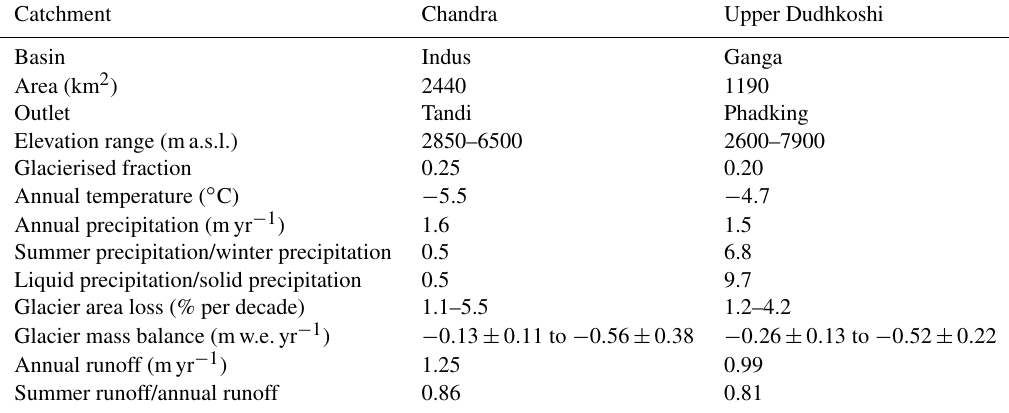
Table 1. A summary of the characteristics of the Chandra and upper Dudhkoshi catchments. The meteorological variables are bias-corrected reanalysis data averaged over the catchments (Hersbach et al., 2020), the hydrological data are from model simulations (the present study). The glacier mass-balance and area-loss estimates are from the existing literature (Table